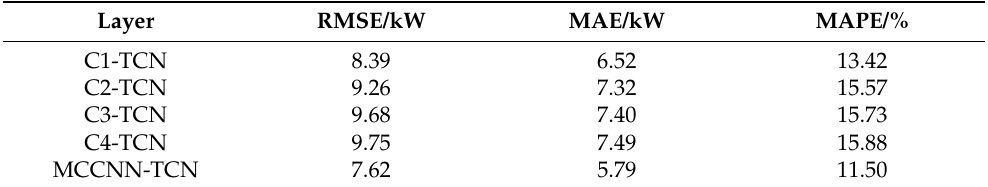
Table 10. Prediction results of single-channel and multi-channel 1D convolutional neural network and temporal convolution network